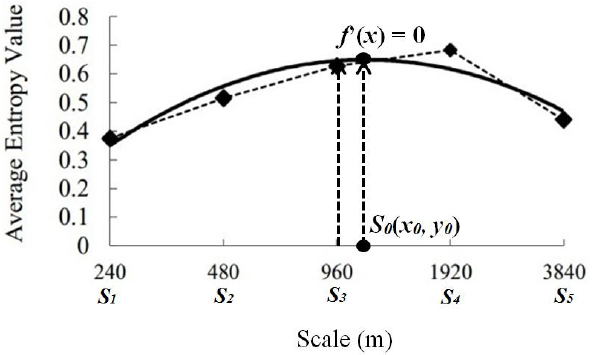
Figure 3. The response of the average entropy value to different scales.